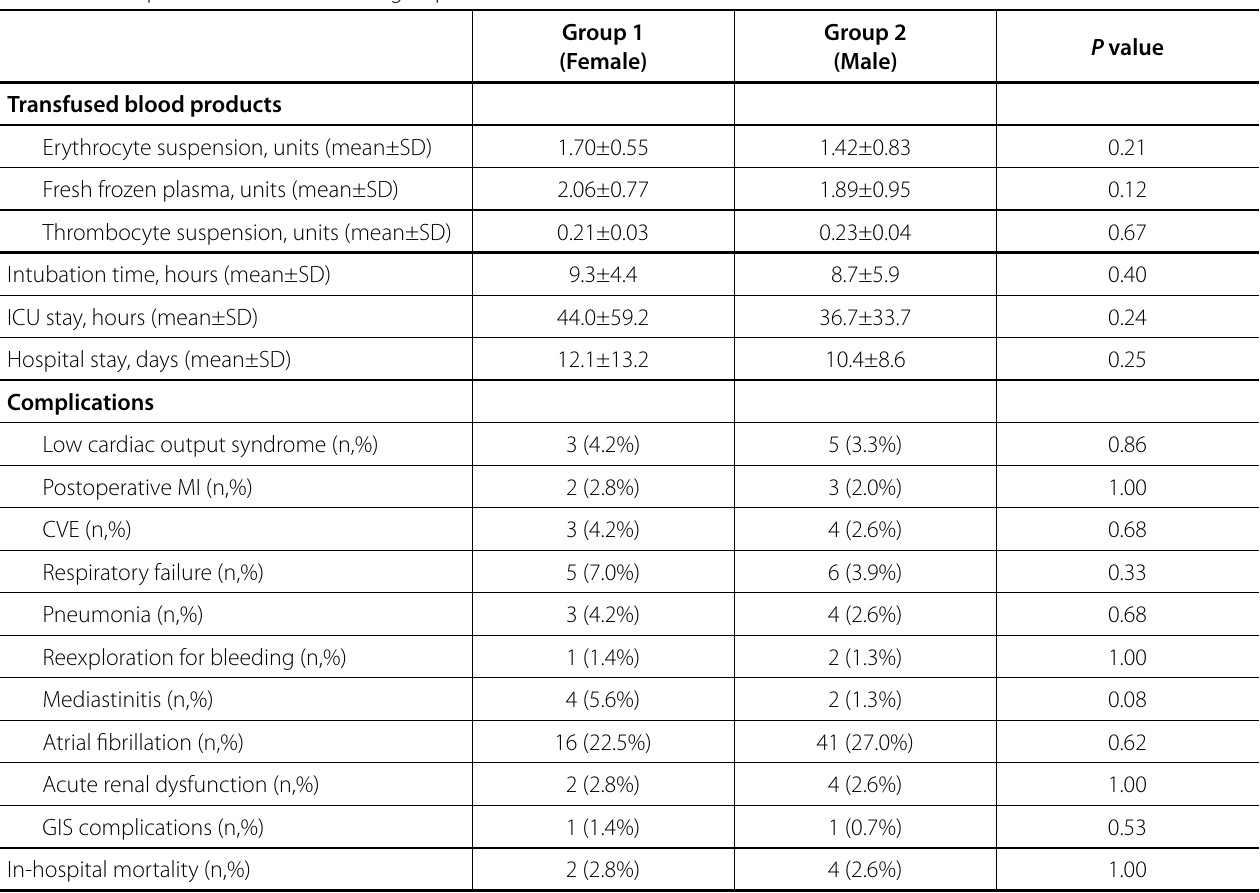
Table 3. Postoperative outcomes of the